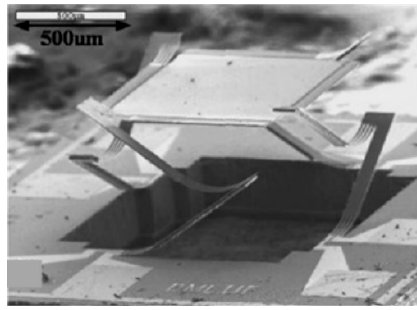
Figure 29. An out-of-plane electrothermal MEMS mirror. (Reprinted with permission from Reference [55] Elsevier).